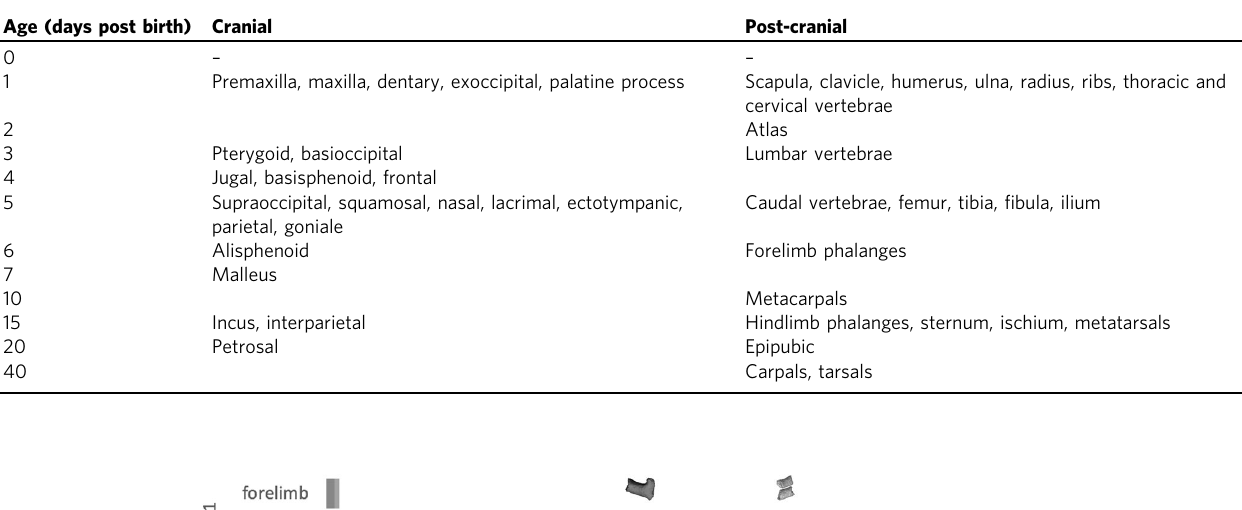
Table 2 Onset of ossi fi cation centres observed in the cranial and postcranial skeleton of S. crassicaudata pouch young.